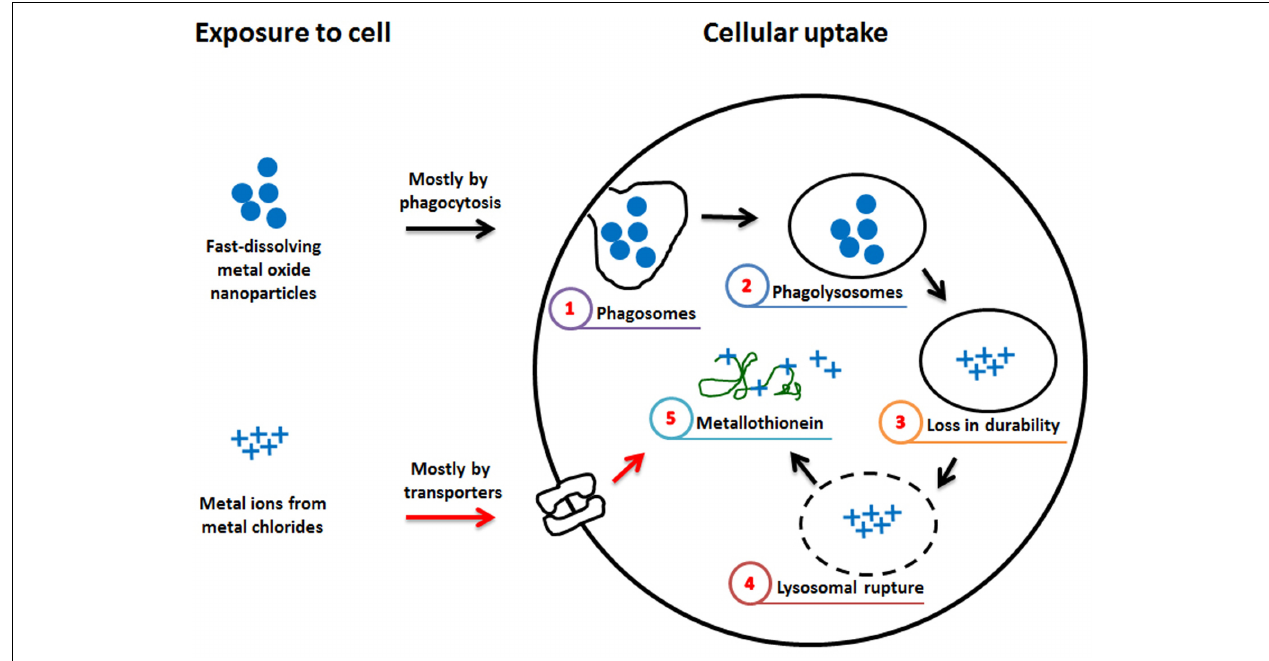
FIGURE 7 | Hypothetical diagram for the differential effect of fast-dissolving metal-oxide NPs and their respective metal chlorides. The differential cytotoxic effect of fast-dissolving metal-oxide NPs and metal ions might be due to the difference in the mechanism of intracellular uptake. NP enters mostly by phagocytosis and (1) phagosomes can fuse with lysosomes to form (2) phagolysosomes. In the acidic lysosomal fluid, fast-dissolving NP can be (3) susceptible to breakdown and its toxic metal ions can (4) rupture the lysosomal membrane. (5) In the cytosol, some of the released metal ions bind with metallothionein, while metal ions outside the cell enter mostly via transporters and (5) bind with metallothionein. The reduced cytotoxicity of ZnO compared to ZnCl 2 might be due to Zn-metallothionein that can act as anti-oxidant, while the comparable cytotoxicity of CoO vs. CoCl 2 and CuO vs. CuCl 2 might be due to Cu-metallothionein that can act as pro-oxidant, although the effect of Co-metallothionein is not known (Hahn et al.,